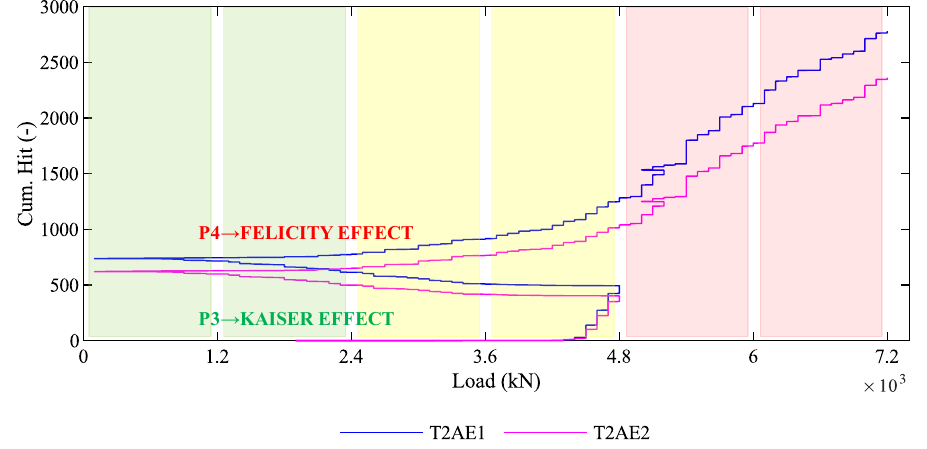
Figure 20. Kaiser and Felicity e ff ects in the AE acquired during the loading phases P3 and Figure 20 . Kaiser and Felicity effects in the AE acquired during the loading phases P3 and P4.